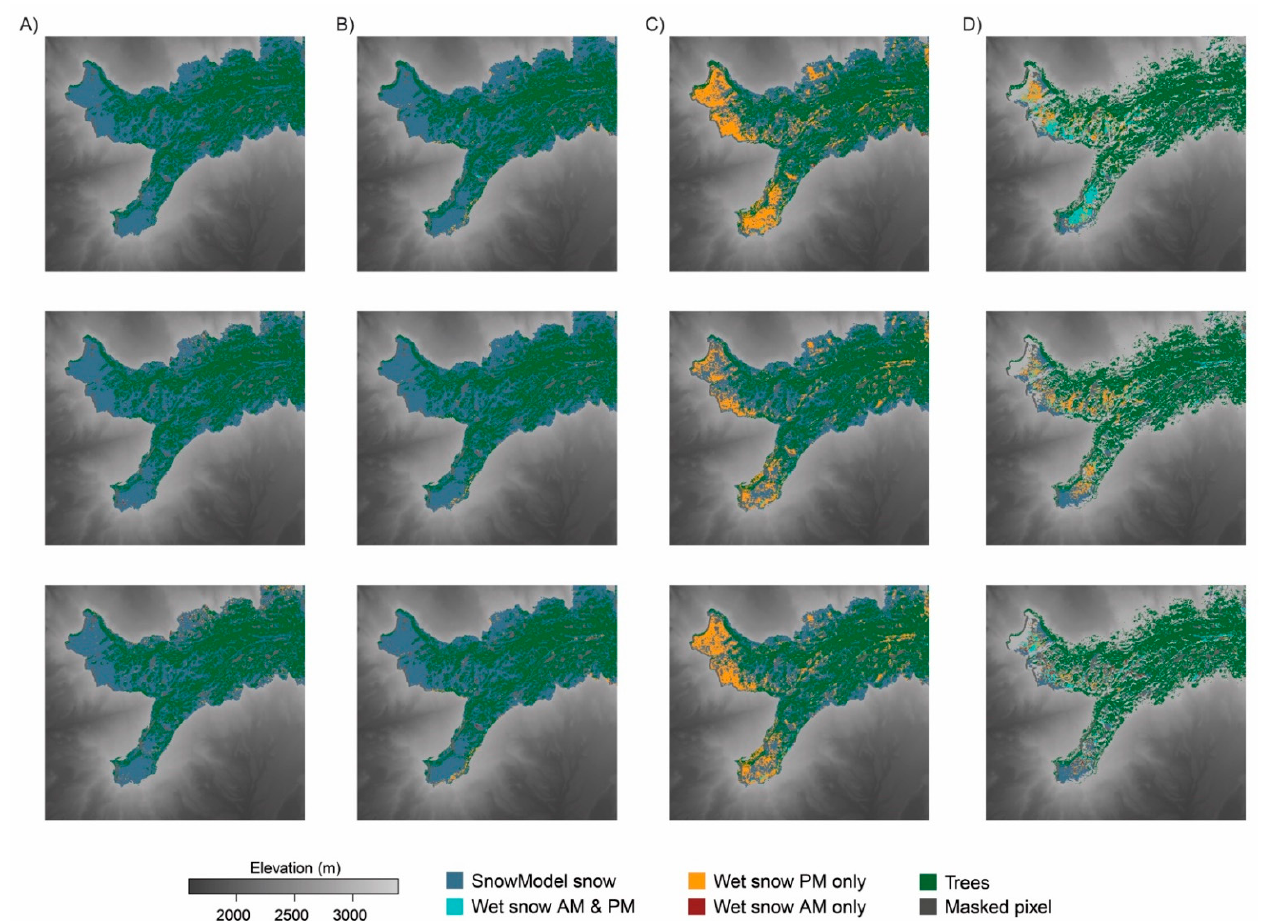
Figure A2. S1 diurnal snow conditions algorithm comparison for four dates: ( A ) 28 January 2020; ( B ) 16 March 2020; ( C ) 9 April 2020; and ( D ) 3 May 2020. Algorithms compared are: − 2 dB co-polarized ratio ( top row ); − 2 dB co-/cross-polarized algorithm [34]; and ( D ) − 1.2 dB co-/cross-polarized algorithm [33].